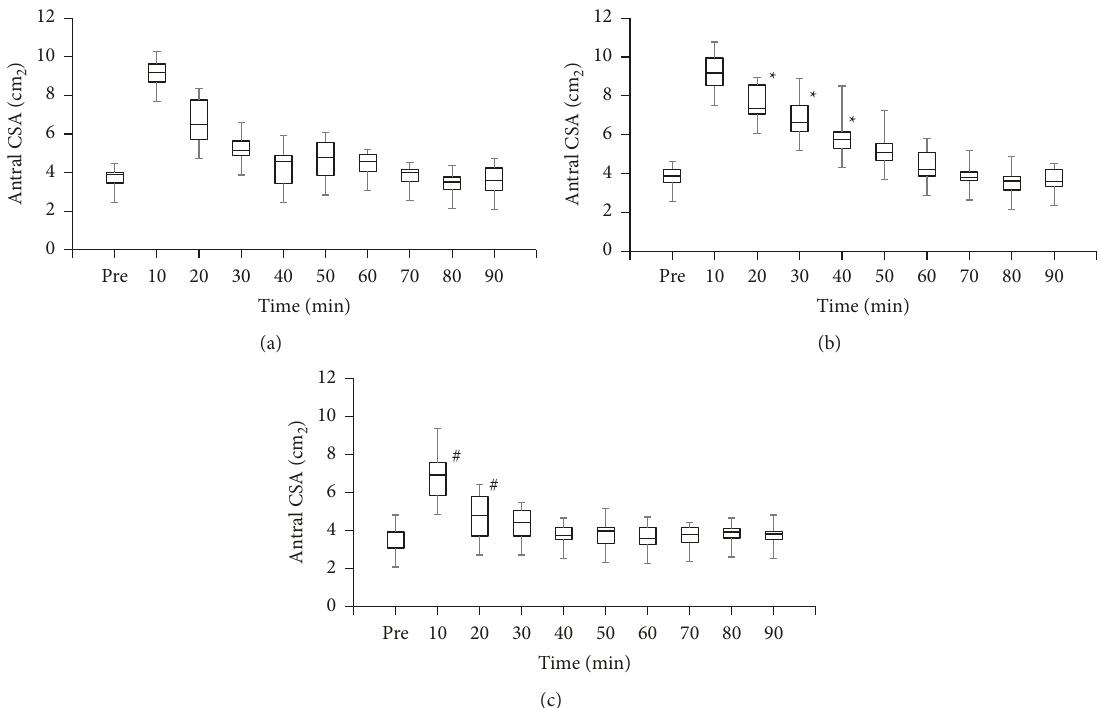
Figure 2: (a) Changes in gastric antral cross-sectional areas (CSA) over time in the whisky group. (b) Changes in gastric antral CSA over time in the sugar group. (c) Changes in gastric antral CSA over time in the water group. Each data point is presented as a box-and-whisker plot. The box denotes the first and third quartiles, with the whiskers representing the range. The median is indicated by a line. Whisky group, 150ml of diluted whisky (30 ml of whisky +120ml of water, 67kcal); sugar group, 150ml of 12.5% glucose solution (67 kcal); water group, 150ml of water (0kcal). ∗ P < 0 . 05, significant difference between the whisky group and sugar group by the Wilcoxon signed-rank sum test with Bonferroni corrections; # P < 0 . 05, significant difference between the whisky group and water group by the Wilcoxon signed-rank sum test with Bonferroni corrections.